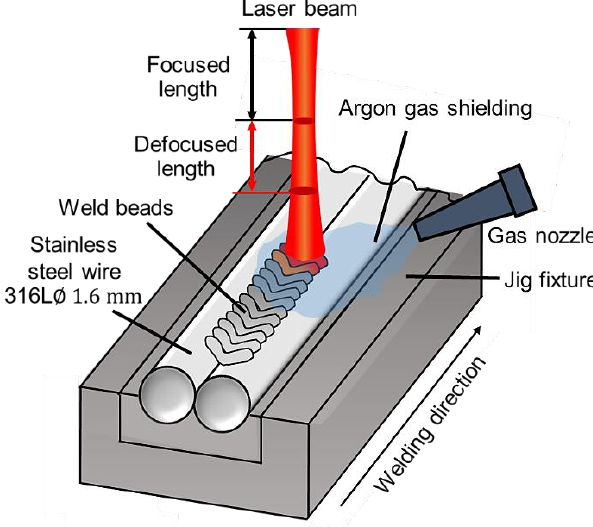
Figure 4. The schematic experimental setup.